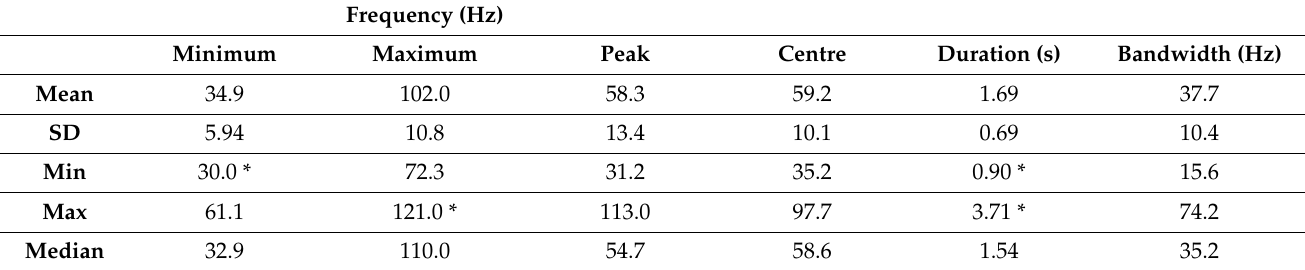
Table 3. Mean, standard deviation (SD), minimum, maximum, and median values for various frequency parameters (in Hz) and duration (in seconds) of high-quality D calls ( n = 596). * Value set a priori, in order to avoid inclusion of other species’ calls (see Section 2.3 in the Materials and Methods).